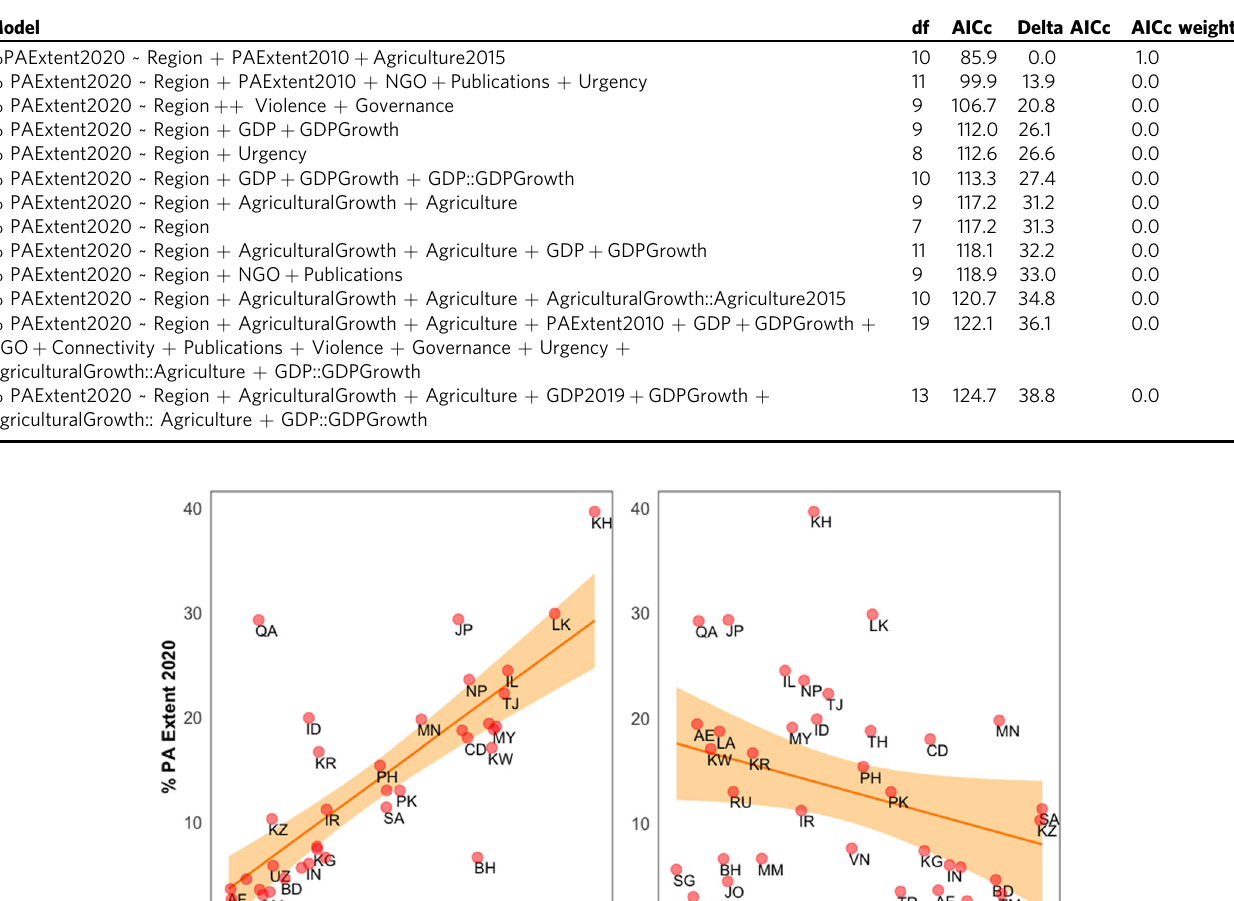
Table 1 Results of generalized linear models testing different hypotheses on the association between the percentage of PA extent in 2020 and ecological and geopolitical factors in Asian countries.